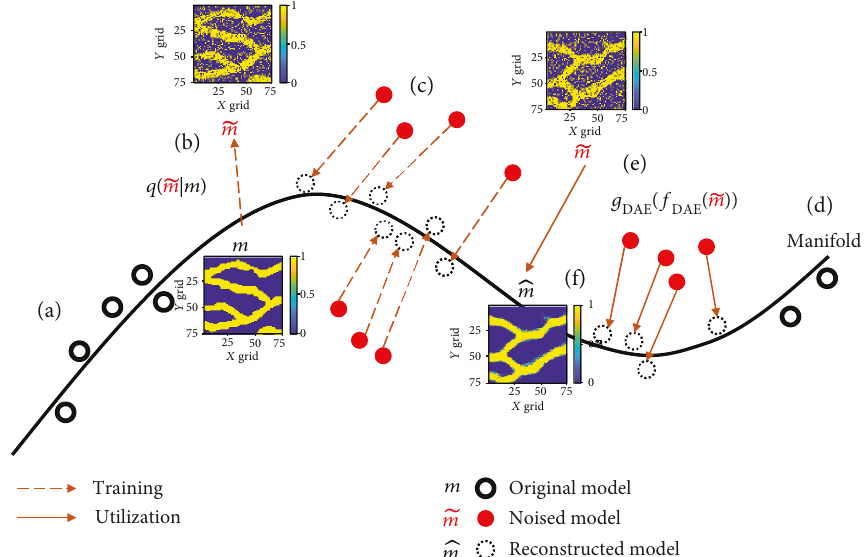
Figure 2: Schematic diagram of manifold learning using a denoising autoencoder (DAE) for geomodels: (a) generating the original models as training outputs; (b) noising the original models stochastically as training inputs; (c) learning of puri fi cation from the noise models to the original models; (d) building of a manifold dimension; (e) applying DAE to the noise models obtained from ES-MDA for obtaining the puri fi ed models; (f) delivering the puri fi ed models to